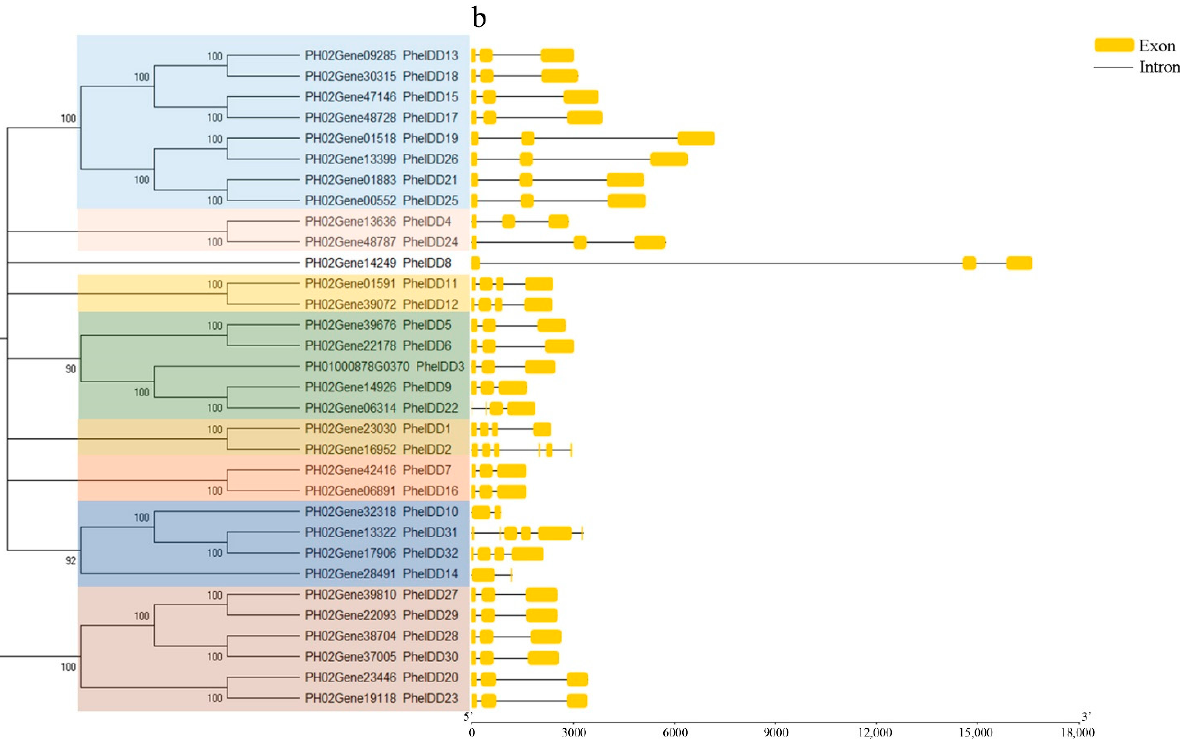
Figure 1. Phylogenetic analysis and schematic gene structures of IDDs in moso bamboo. ( a ) A phylogenetic tree of IDD homologs in moso bamboo. The tree was constructed by the neighbor- joining method using MEGA6.0 software with default parameters. Numbers at the nodes indicate bootstrap values (as percentages) calculated for 1000 replicates. Sub-groups are highlighted with colored boxes.( b ) Schematic representation of PheIDD genes. Exons are shown as boxes and introns as